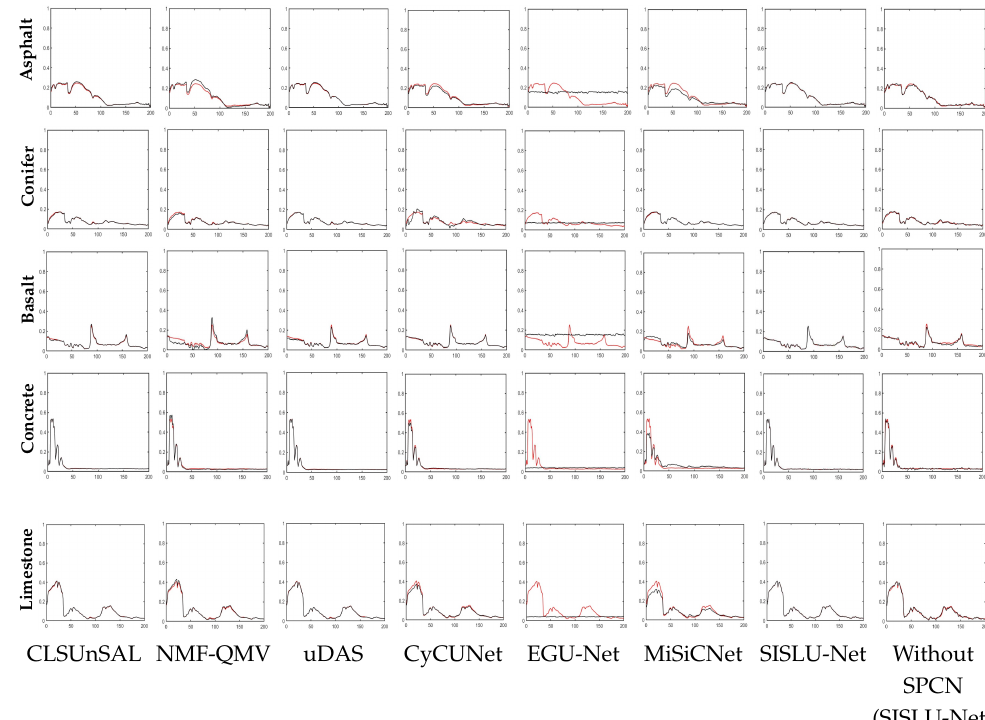
Figure 8. Estimated endmembers by all competing methods on the Synthetic Dataset. Red: the ground truth endmembers; Black: the estimated endmembers.